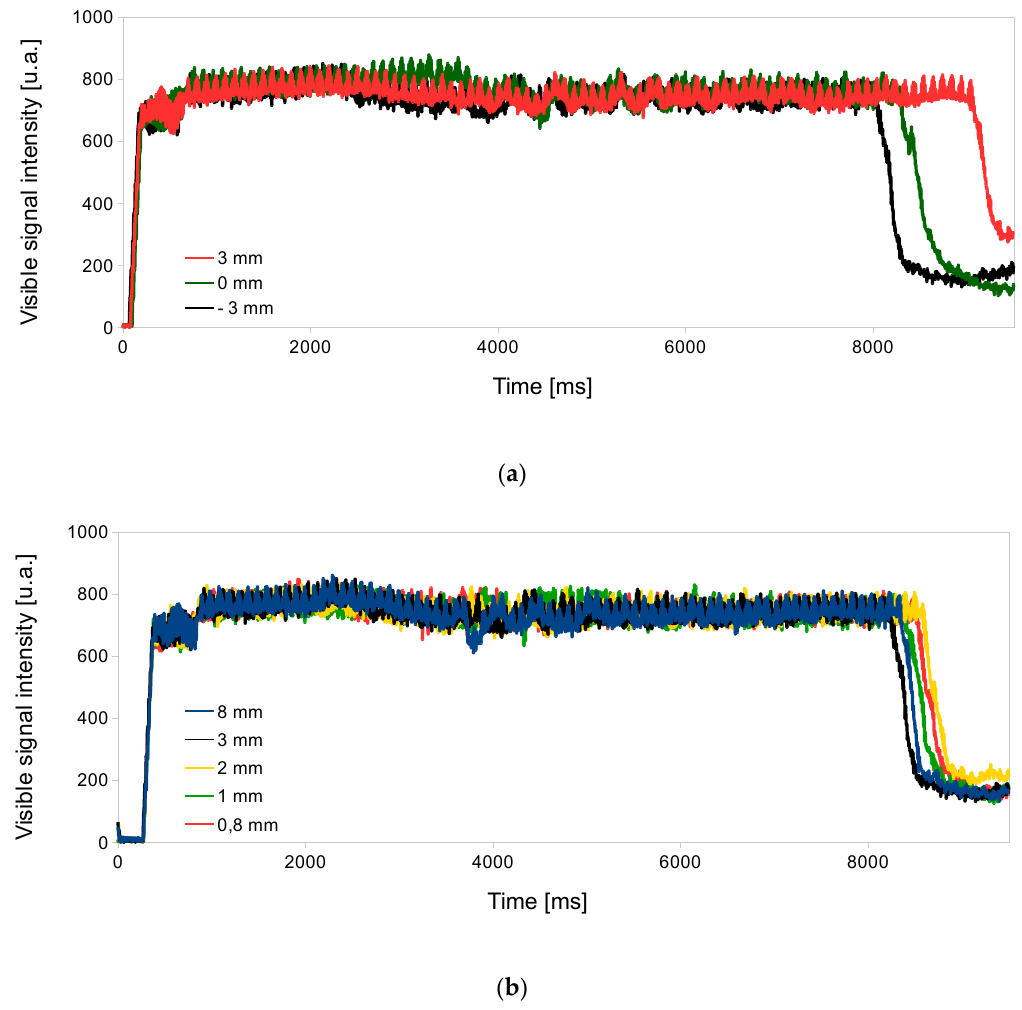
Figure 2. Piercing monitored signal for mild steel 20 mm thick, varying ( a ) focal position; ( b ) standoff.